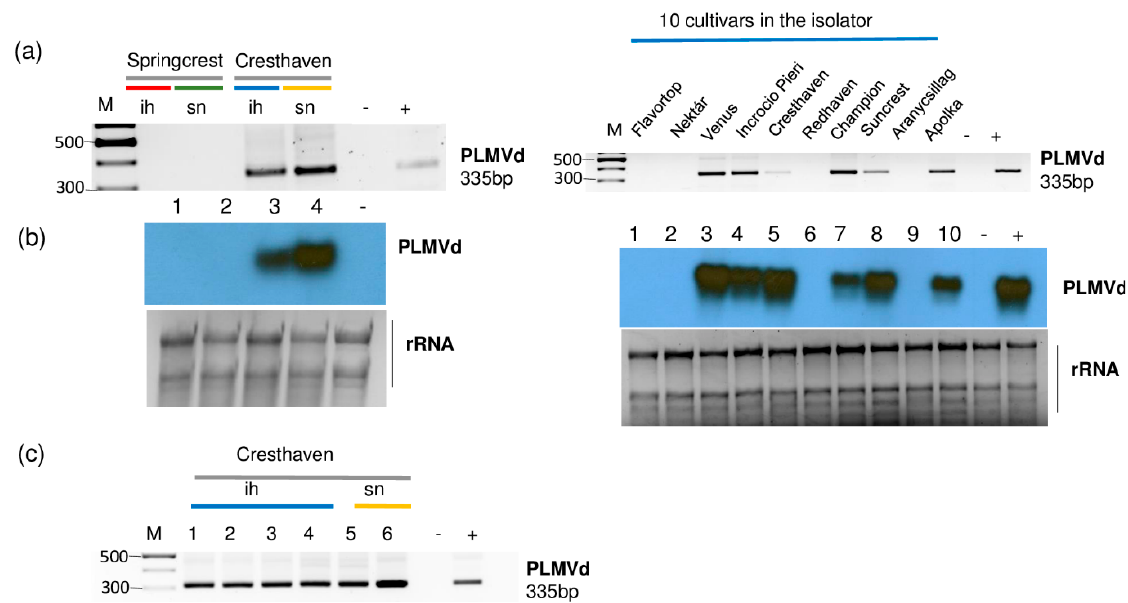
Figure 8. The result of the validation for the presences of PLMVd by ( a ) RT-PCR using PLMVd-specific primers amplifying a 335 bp viroid-specific amplicon or ( b ) Northern blot using a PLMVd-specific radiolabeled probe in the sRNA HTS libraries. ( c ) The result of the RT-PCR validation for the presences of PLMVd in individual Cresthaven trees using viroid-specific primers amplifying a 335 bp viroid-specific amplicon. M is a GeneRuler 100 bp from Thermo Scientific. ih: isolator house; sn: stock nursery; + is a positive control; − is a negative